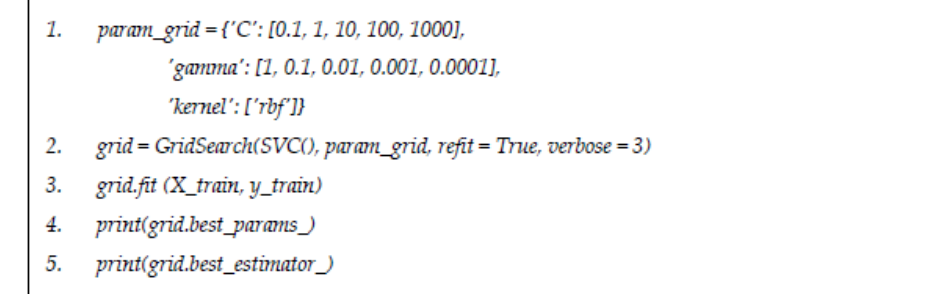
Figure 3. Command for parameter and estimator for support vector machine classifier.